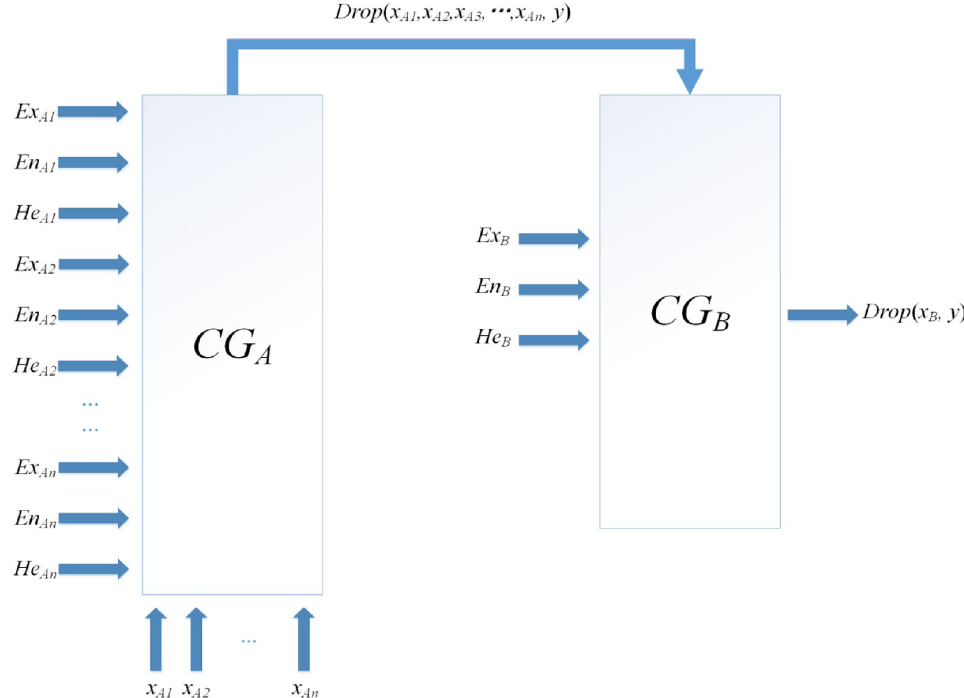
Figure 5. Many conditional single regulations cloud